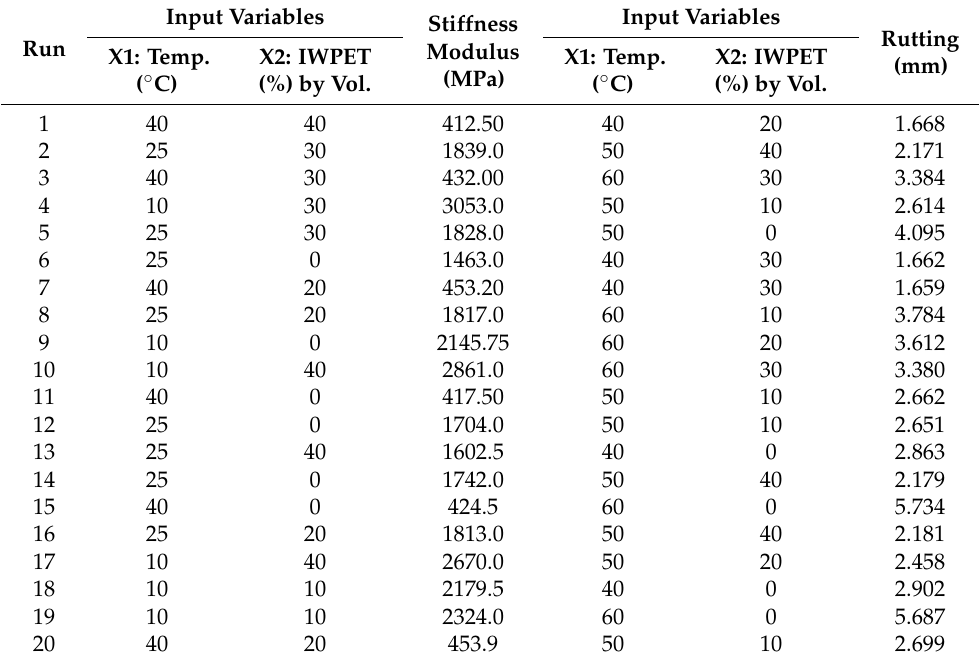
Table 4. Matrix of experimental design for stiffness and rutting